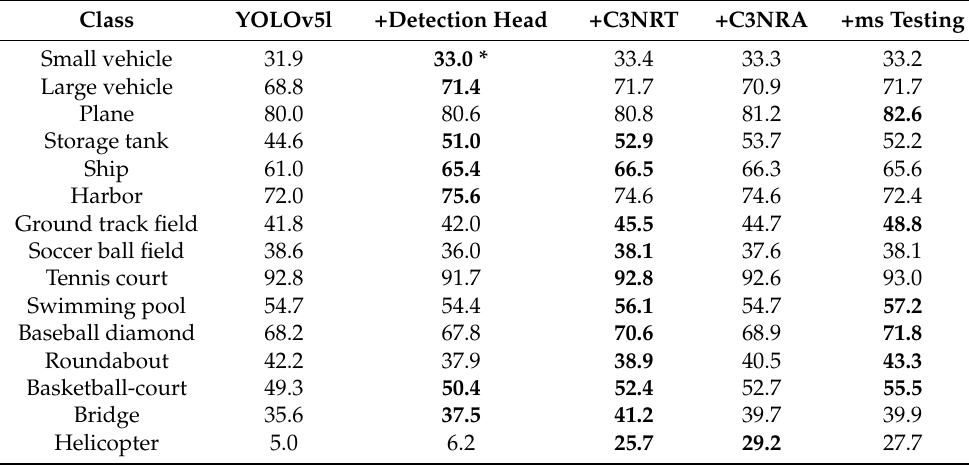
Table 5. Ablation study of different classifications (mAP 0.5 ).